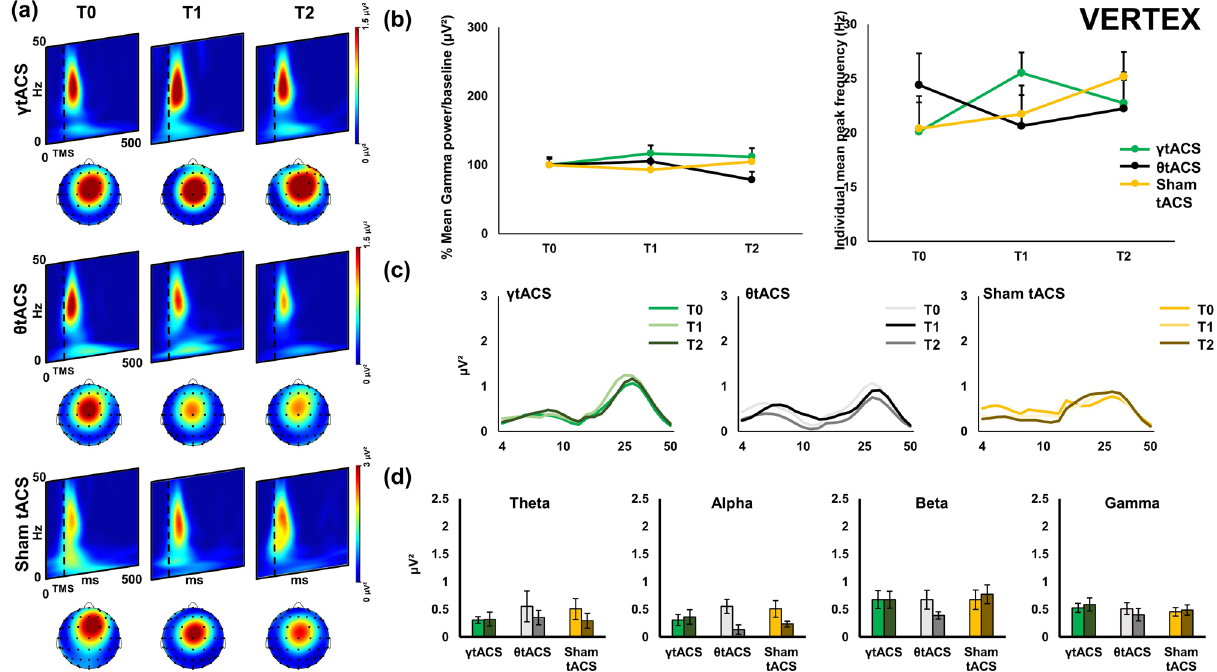
Figure 3. Local transcranial magnetic stimulation (TMS)-evoked cortical oscillations of the Vertex. Panel ( a ) represents time–frequency oscillations for the three stimulation conditions and time points. Topographical maps depict the spatial cortical activation during TMS-EEG (50 ms after TMS pulse, 25 Hz). All maps and time–frequency representations were generated by BrainVision Analyzer (v 2.2; https:// www. brain produ cts. com/ solut ions/ analy zer/). Panel ( b ) shows the power and shifting analysis performed on cortical oscillations. The panel represents on the left the % changes of the Gamma frequency in terms of power with respect to baseline. Moreover, the right side of the panel shows the shifting of the individual frequency in terms of Hz with respect to the three time points. Furthermore, panel ( c ) shows power expression of the whole frequency spectrum calculated for the cortical oscillations analysis. Lastly, panel ( d ) shows the four frequency bands considered for the analysis (Theta, Alpha, Beta, Gamma) and their change in power (μV 2 ) during time (T0, T1, T2) for every stimulation